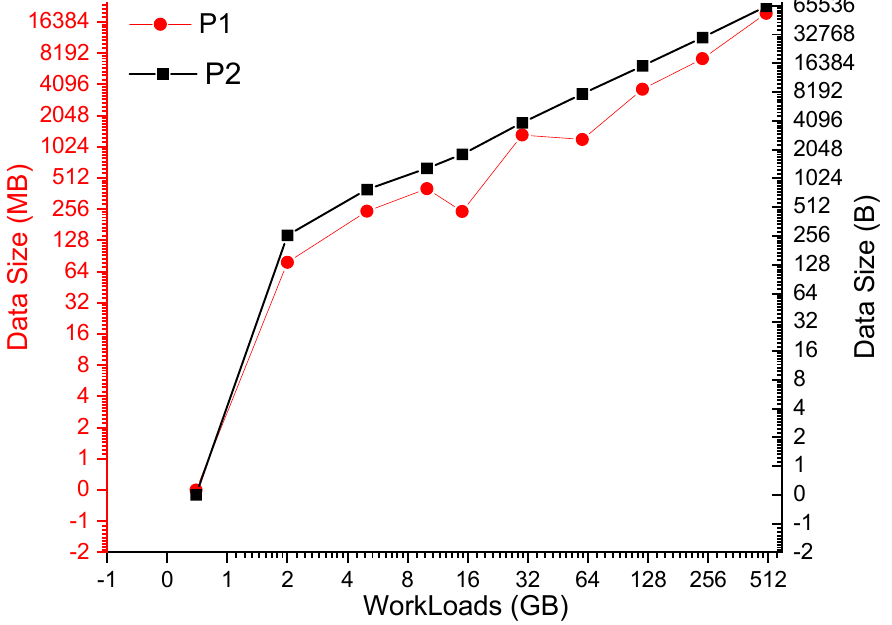
Figure 14. Additional space cost required for checkpoints persisting for WordCount and FilterWord jobs in s2p-flink under various